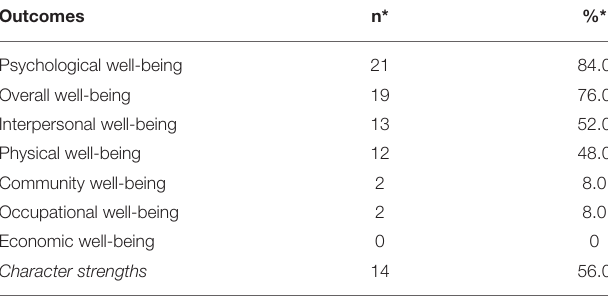
TABLE 5 | Number of programs with at least one target outcome belonging to the different well-being categories ( n =